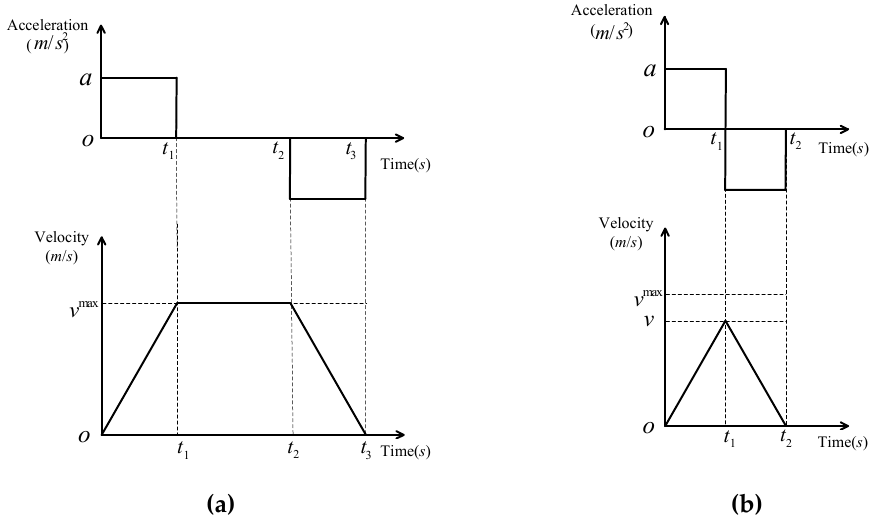
Figure 4. Operation Features of shuttles and lifts. ( a ) Patterns of acceleration and velocity for situation 1 ; ( b ) Patterns of acceleration and velocity for situation 2. ( b ) Patterns of acceleration and velocity for situation